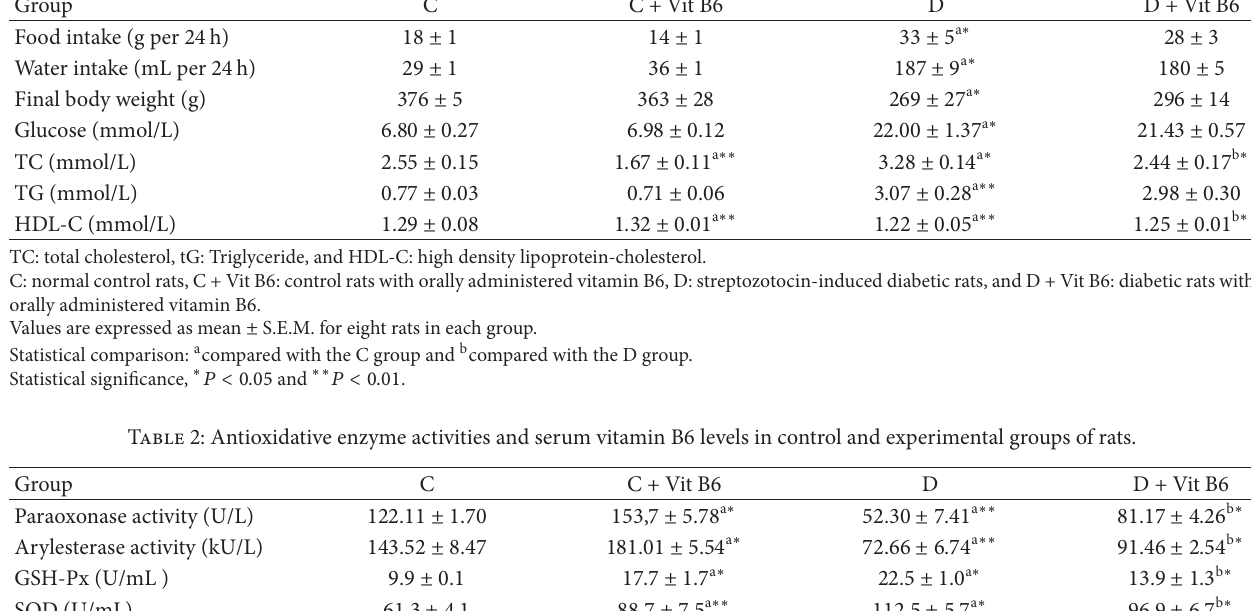
Table 1: Body weight, food and water consumption, and metabolic parameters of the control and experimental groups of rats. Group C C + Vit B6 D D + Vit B6 Food intake (g per 24 h) 18 ± 1 14 ± 1 33 ± 5 a ∗ 28 ± 3 Water intake (mL per 24h) 29 ± 1 36 ± 1 187 ± 9 a ∗ 180 ± 5 Final body weight (g) 376 ± 5 363 ± 28 269 ± 27 a ∗ Glucose (mmol/L) TG (mmol/L)